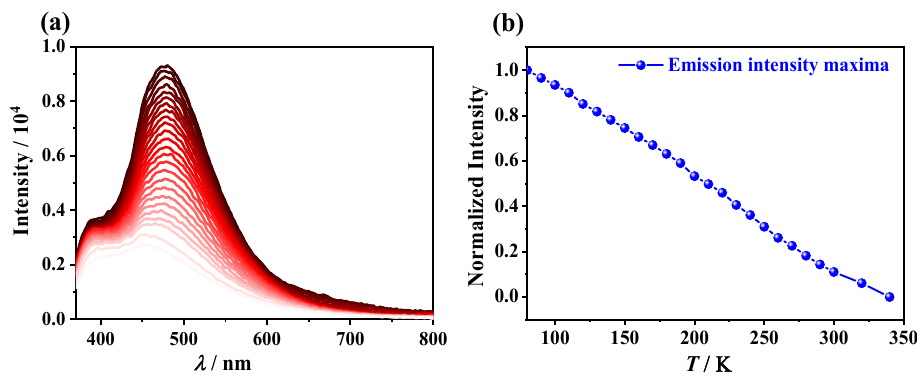
Figure 6. ( a ) Variable-temperature fluorescence emission spectra of 1 ; ( b ) Normalized maximum fluorescence emission intensity of 1 as a function of temperature .